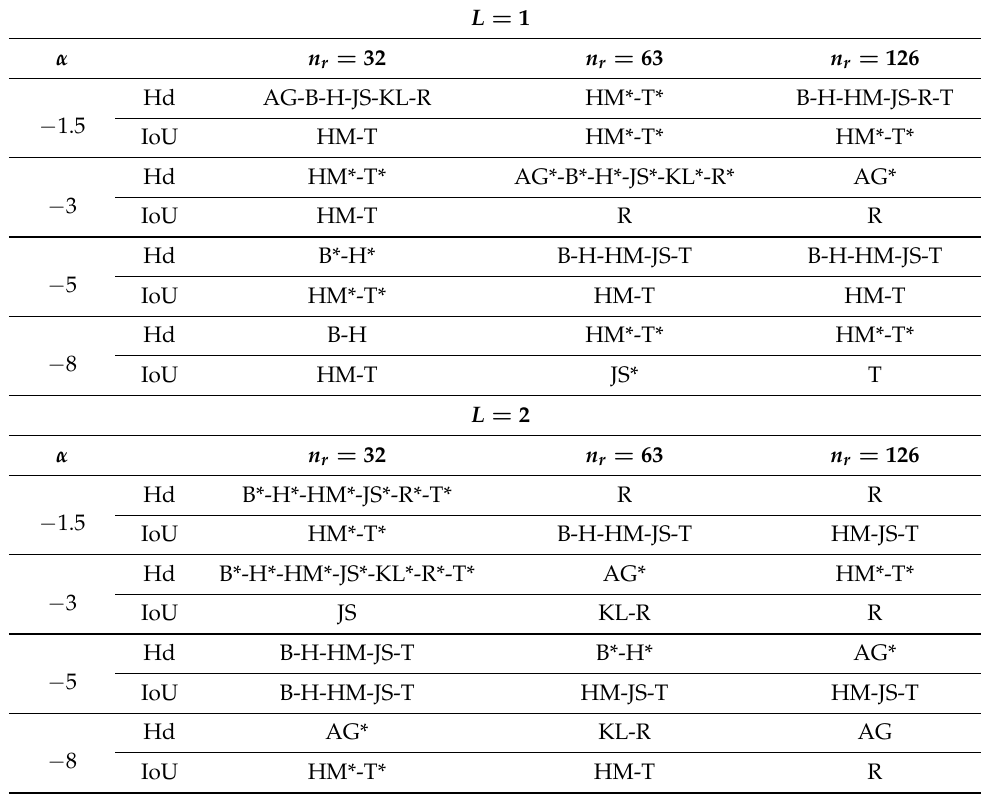
Table 4. Stochastic measures with the best performance per texture for simulated data.